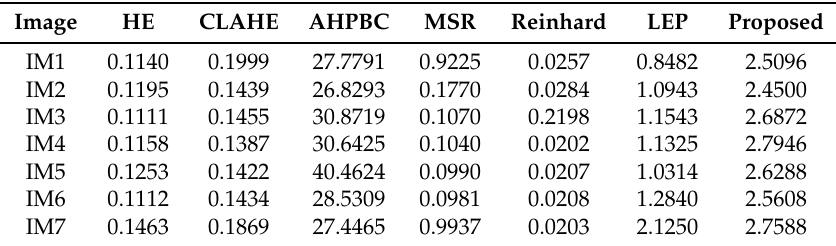
Table 6. Running time of the test images. Unit: